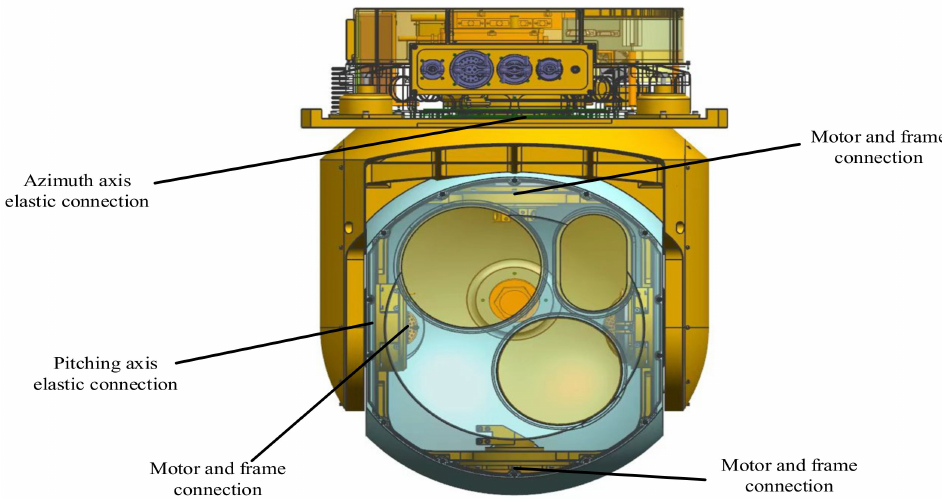
Figure 2. Elastic position distribution of aero-optical stabilization